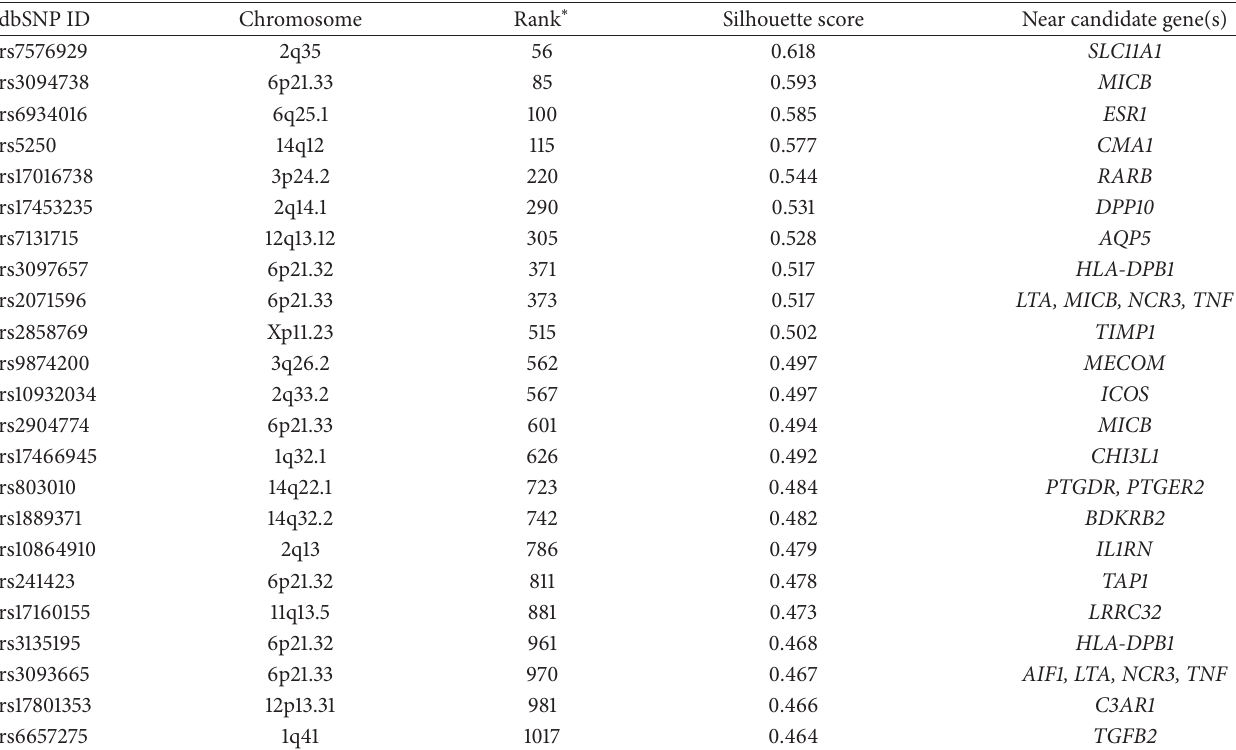
∗ Ranking based on the pooled